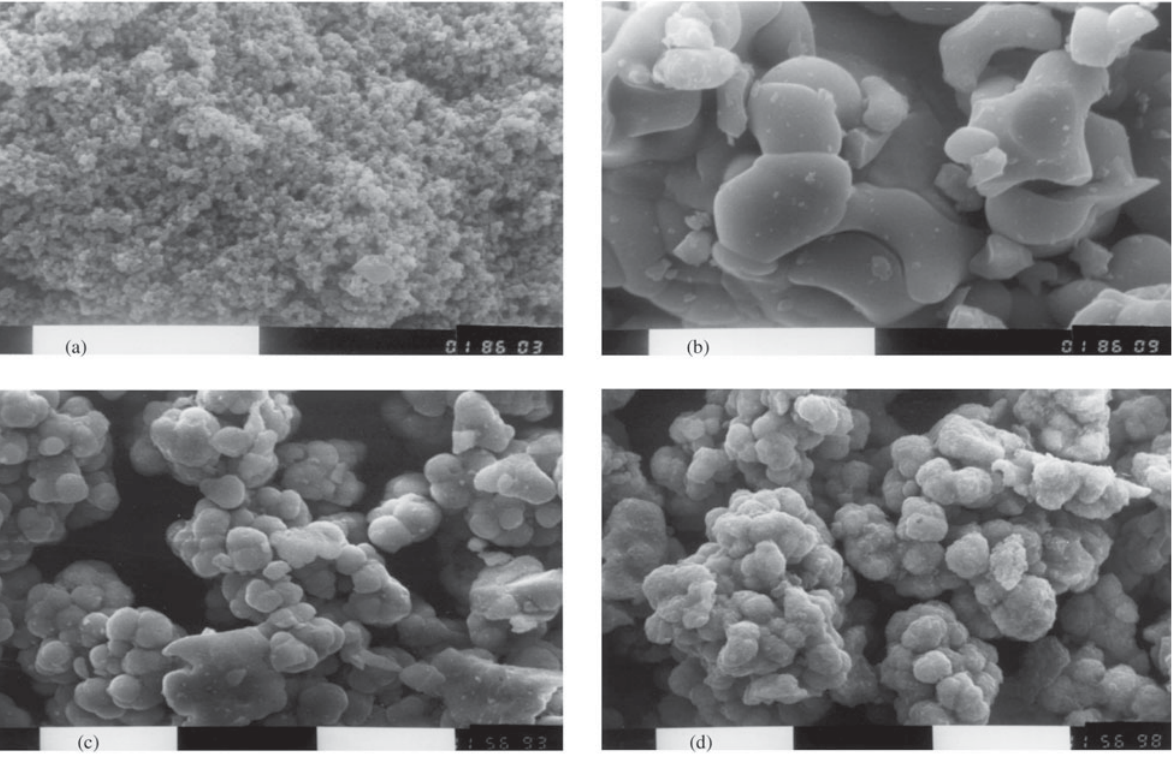
Figure 7. Micrographies (SEM) of reagents and products (scale: white bar = 10 µ m). a) Anatase; b) A200 sample treated at 1650 °C; c) Badeleyite; d) B300 sample treated at 1650 °C.